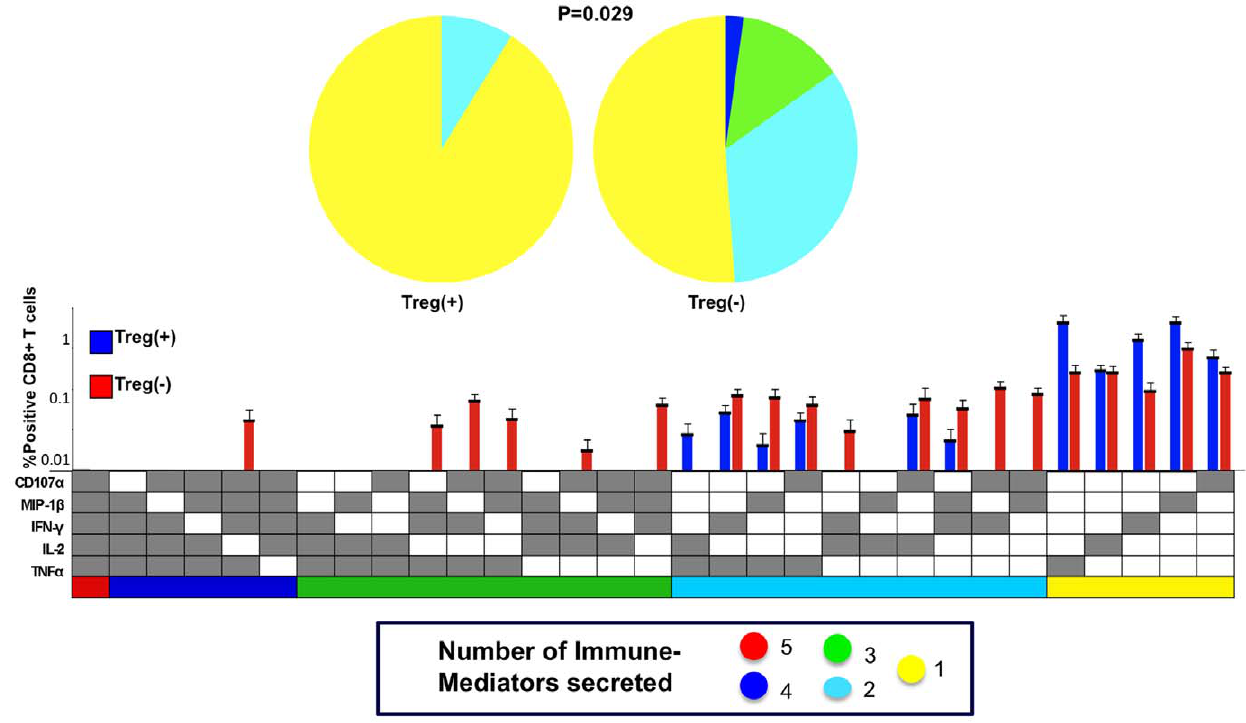
Figure 6. Polyfunctionality of the total vaccine response with (Treg + ) and without Treg (Treg 2 ). The total vaccine response was obtained by subtracting the pre-vaccine response from the post-vaccine response and represents the vaccine-induced change in CD8 + T cell secretion of immune mediators from baseline. Analysis by permutation comparison showed a significant increase in polyfunctional response to Gag peptide in the samples depleted of Treg. (P=0.029;